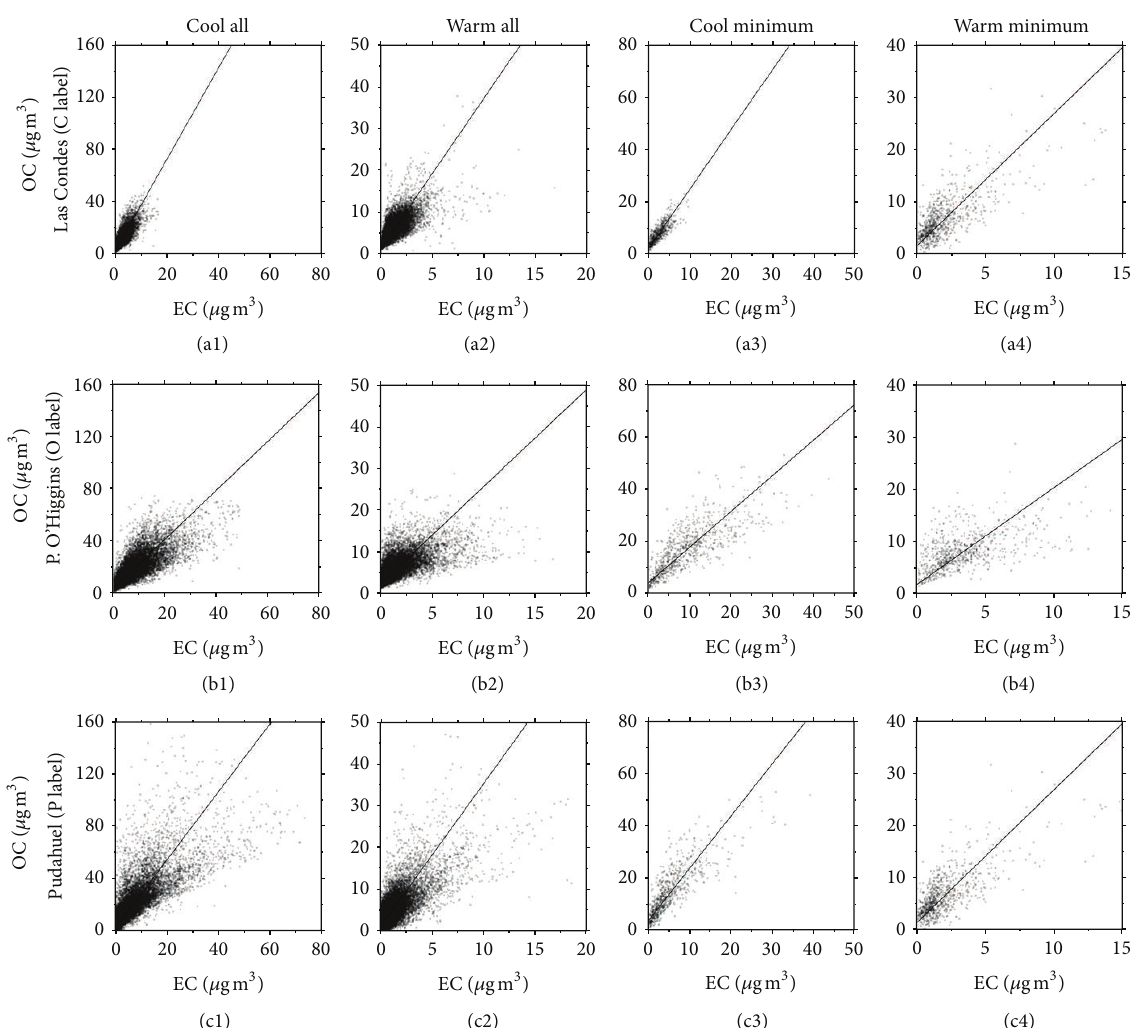
Figure 5: Scatter plot of OC and EC in PM 2.5 , corresponding to the hourly cool and warm season datapairs, for the period from 2002 to 2007 at the three stations studied. Figures i1 and i2 (i = a, b and c) show scatter plots of all data available for the years of the study in a cool (1) and warm (2) seasons of all years. Figures i3 and i4 (i = a, b and c) show scatter plots of the minimum OC/EC ratio in the cool (3) and warm (4) seasons during the years of the study. Label of the stations in Figure 1. Las Condes: C Label, P. O’Higgins: O Label, and Pudahuel: P Label.